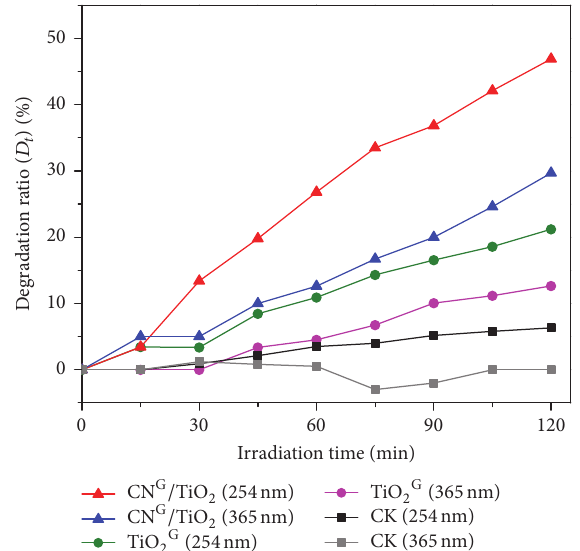
Figure 5: Photodegradation of MO catalyzed by TiO 2 G , CN G /TiO 2 , and 2 blank samples (without catalysts) under UV irradiation ( 𝜆 = 254, 365